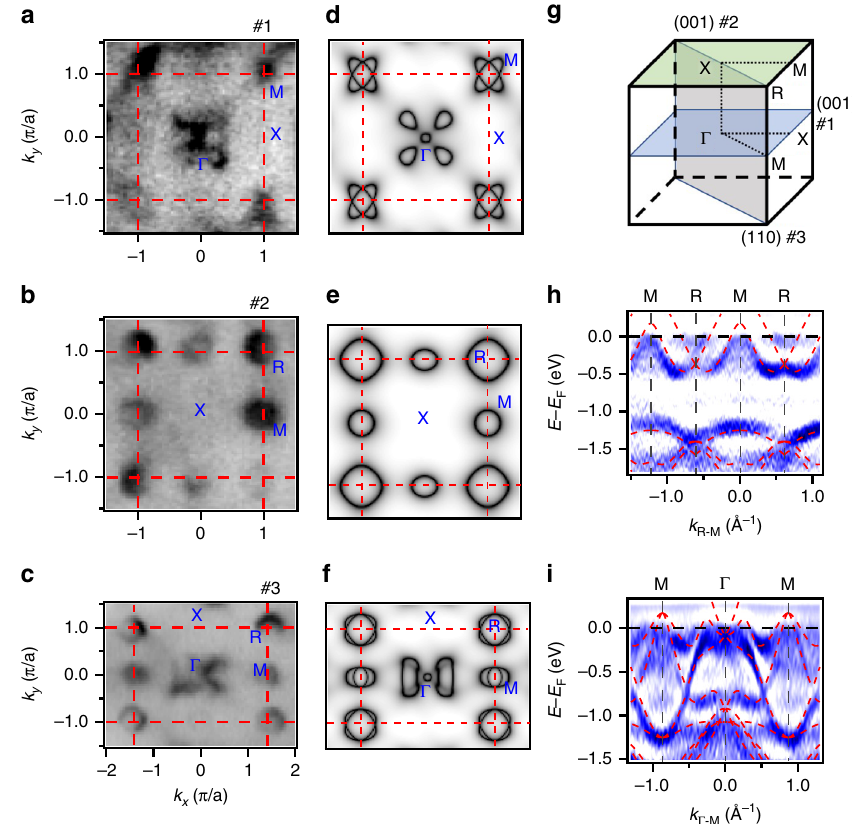
Fig. 2 FSs and band structures of bulk states of RhSn. a – c ARPES intensity maps at E F showing the FSs in three high-symmetry planes #1 ( a ), #2 ( b ) and #3 ( c ). d – f Calculated FSs in planes #1 ( d ), #2 ( e ) and #3 ( f ). The dashed red lines in a – f indicate the bulk BZ boundary. g Locations of planes #1, #2 and #3 in the bulk BZ. h , i Curvature intensity maps of the ARPES data along M- Γ -M ( h ) and R-M-R ( i ). For comparison, we plot the corresponding calculated bands as red dashed curves on top of the experimental data in h and i . The ARPES data in a , b , c , h and i were collected with h ν = 344, 390, 395, 435 and 490 eV,